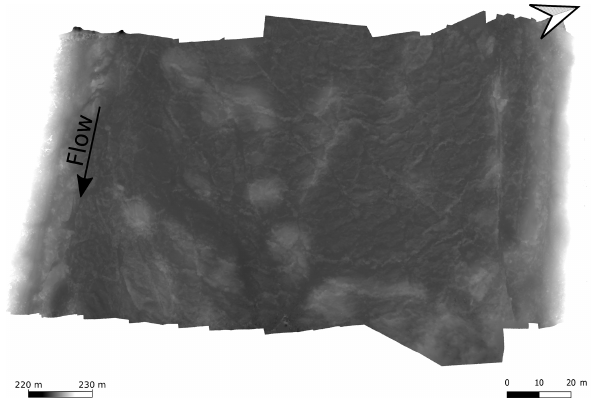
Figure 6. Example DEM: DRLL06, 21 November